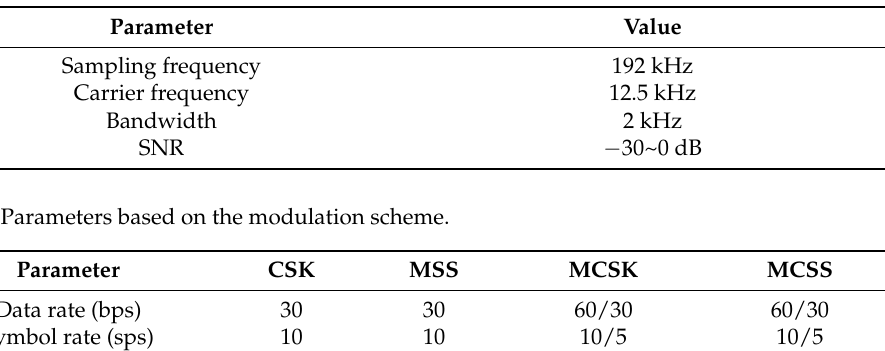
Number of sequences 127